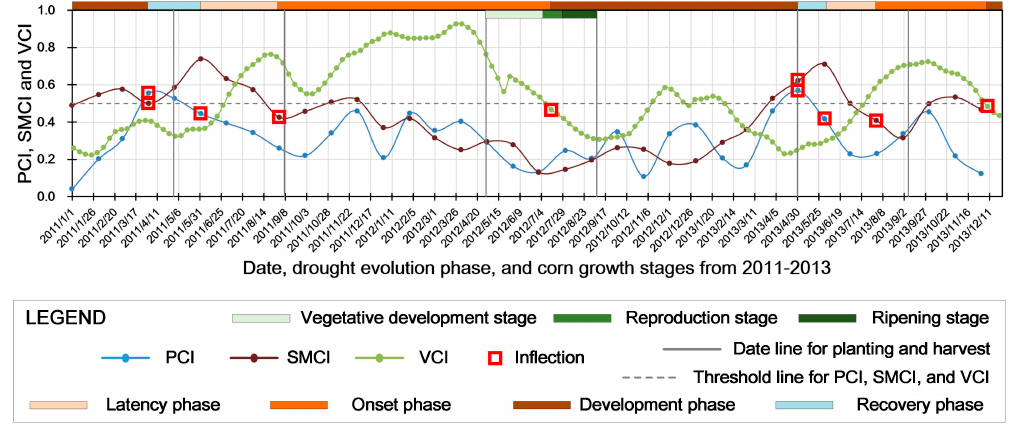
Figure 2. The temporal evolutions of PCI (blue line), SMCI (brown line), and VCI (green line) in the study area from 2011 to 2013 using the EPMC method. Corn growth period with three stages in 2012, thresholds, and four drought evolution phases with the inflection time points are marked. Vegetative development stage is marked as light green strip. Reproduction stage is marked as green strip. Ripening stage is marked as bottle green strip. Latency phase is marked as faint yellow strip. Onset phase is marked as orange strip. Development phase is marked as pomegranate strip. Recovery phase is marked as light blue strip. An inflection time point presents the change of drought phases defined in EPMC. A period of time between two inflection points is the duration of one phase.